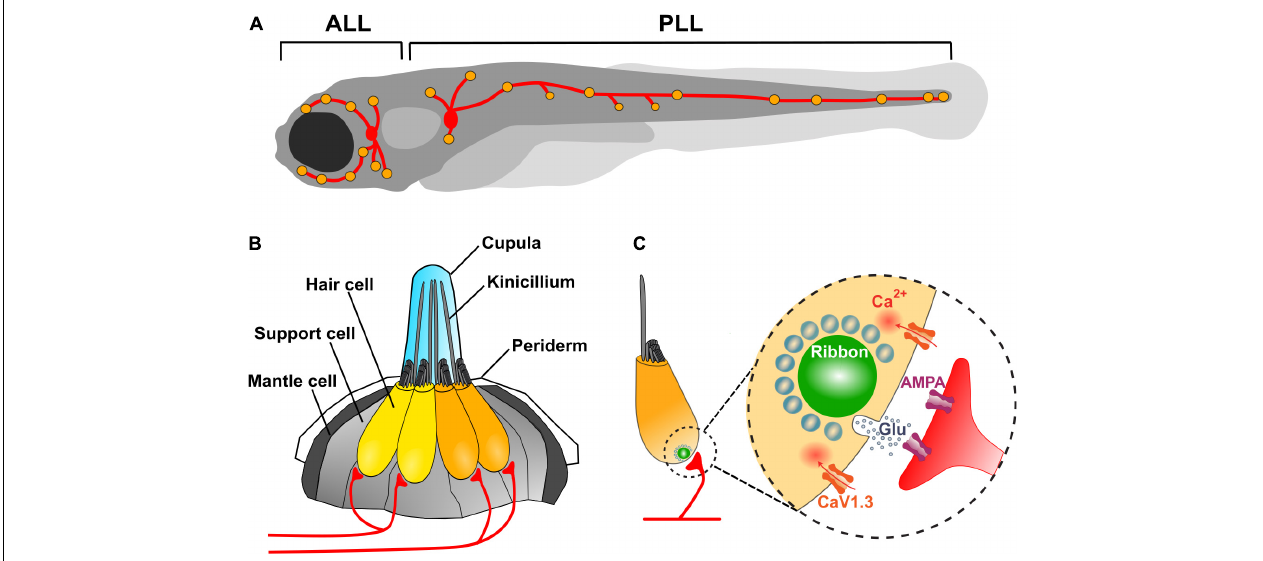
FIGURE 1 | Zebrafish lateral line neuromasts and their afferent innervation. (A) Schematic depicts a larval zebrafish. Yellow patches indicate the location of neuromasts in the LL system. Red patches represent the location of the anterior (ALL) and posterior (PLL) LL ganglia. The neurons in these ganglia project to and innervate HCs in the LL. (B) A side view of a single LL neuromast. HC (yellow and orange) are surrounded by supporting cells (light gray) and innervated by both afferent (red) and efferent neurons (not shown). Mantle cells (dark gray) outline the neuromast and contact the periderm cells of the larva’s integument. Apical mechanosensory hair bundles and kinocilia are contained within a gelatinous cupula and project out into the water. A neuromast contains two populations of HCs of opposing hair bundle polarities (yellow and orange). Each afferent neuron (red) exclusively synapses with HCs of identical planar orientation. (C) Diagram of a single HC. HCs are activated when hair bundles are deflected and mechanosensitive channels open allowing the influx of cations. This apical activity depolarizes the HC, resulting in presynaptic Ca 2 + influx and release of glutamate onto the afferent neuron. A presynaptic density called a ribbon (green) helps to recruit synaptic vesicles (light blue circles) to the synapse near clusters of CaV1.3